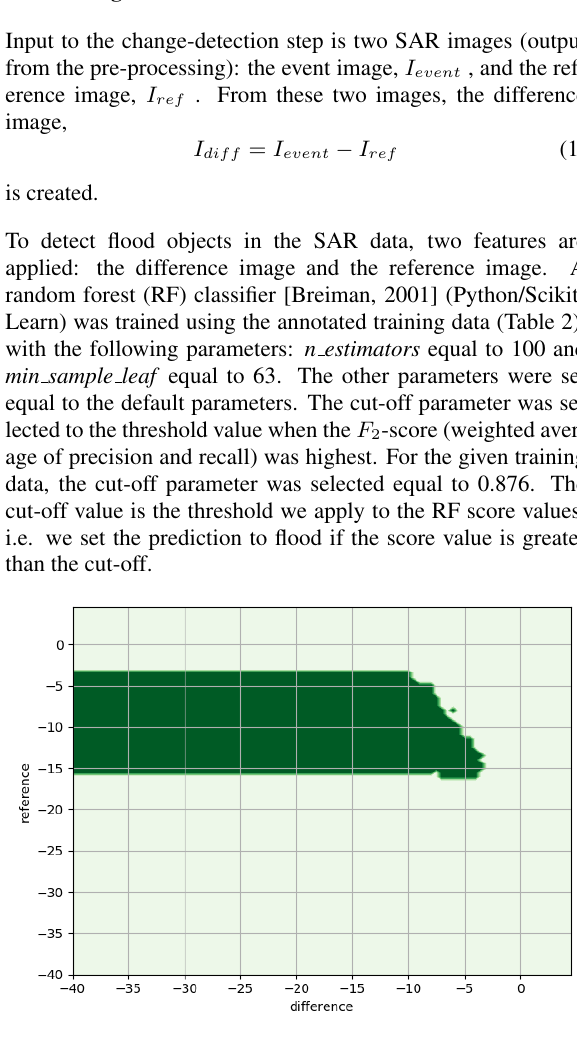
Figure 2. Decision boundaries of the trained RF classifier. For feature values within the green area, the RF classifier predicts